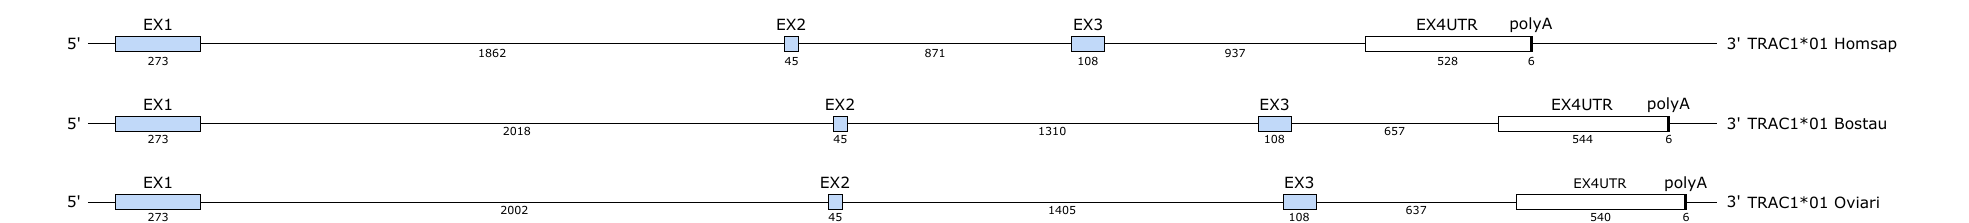
Figure 1. Structure of the TRAC genes in human (Homsap), bovine (Bostau) and sheep (Oviari). The numbers correspond to the size of the exons and introns in nucleotides.